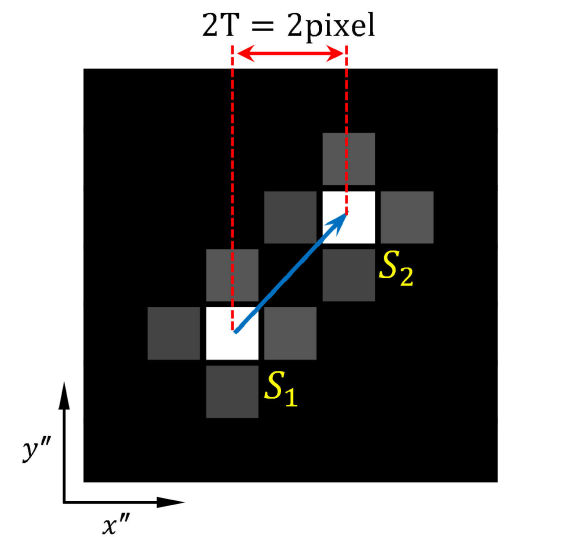
Figure 2. Whether in x (cid:48)(cid:48) or y (cid:48)(cid:48) direction, the centroid position of the imaging spot is the same as the centroid position of the imaging spot after being translated by one image sensor pixel. S 1 is the initial imaging spot, S 2 is the imaging spot over one periodic translation and T is the translation period of the imaging